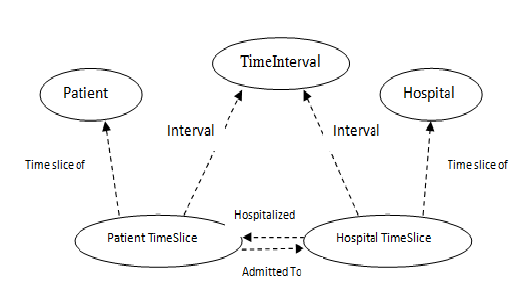
Figure 4.Utilizing 4D-fluent to represent a patient’s relations to a hospital.